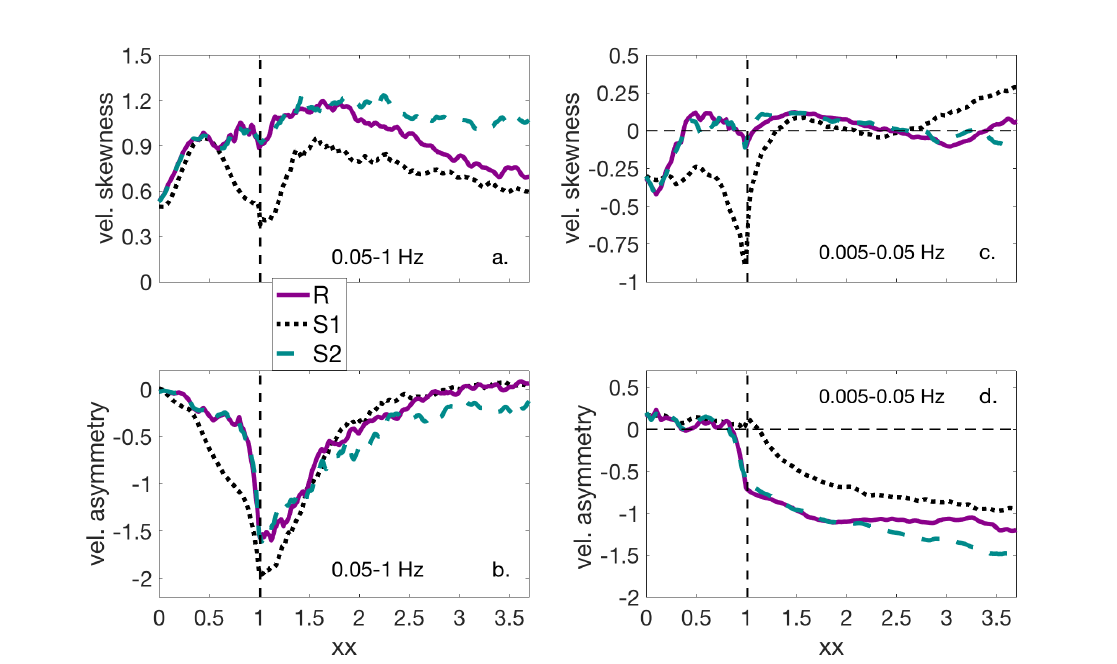
Figure 6. Modeled short wave velocity skewness ( a ) and asymmetry ( b ), and IG wave velocity skewness ( c ) and asymmetry ( d ) for slopes R , S 1 and S 2 on a normalized grid ( xx ) from the beginning of the seaward slopes ( xx = 0) to the back barrier basin ( xx = 3.7). Grid locations before the crest (indicated by the vertical dashed line) indicate output in the same water depth (but not the same distance in reference to the crest), while they are equidistant and at the same depth after the crest for R and S 1 (but not for S 2 for which the island top has the same height as the